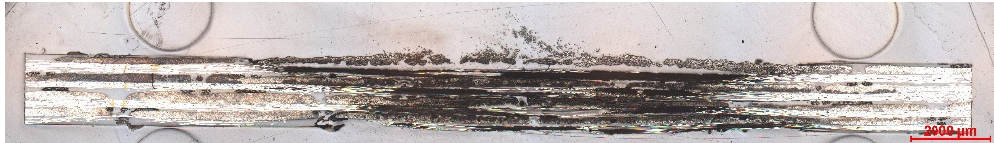
(d) Figure 5. Scanning electron microscopy (SEM) images of the filaments: ( a ) reference, ( b ) reference without the sizing agent, ( c ) detached and treated with 66% power, and ( d ) detached and treated with 96% power.